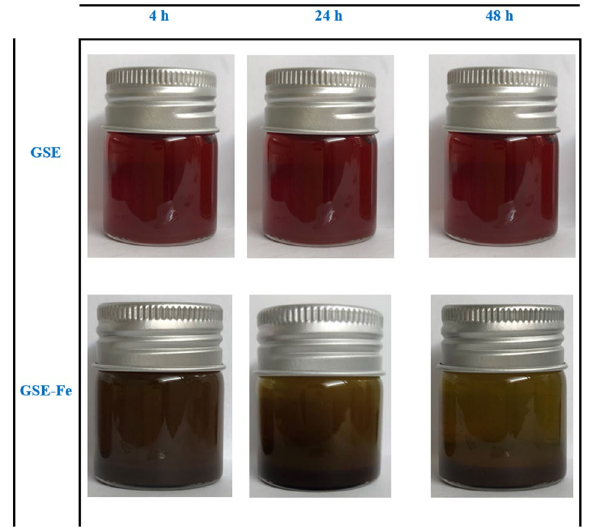
Figure 17. Stability of samples taken from HCl solution and complexes at different interval times.